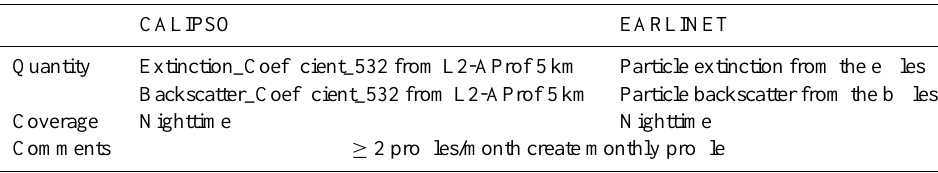
Table 1. Characteristics of CALIPSO and EARLINET data considered for this analysis.